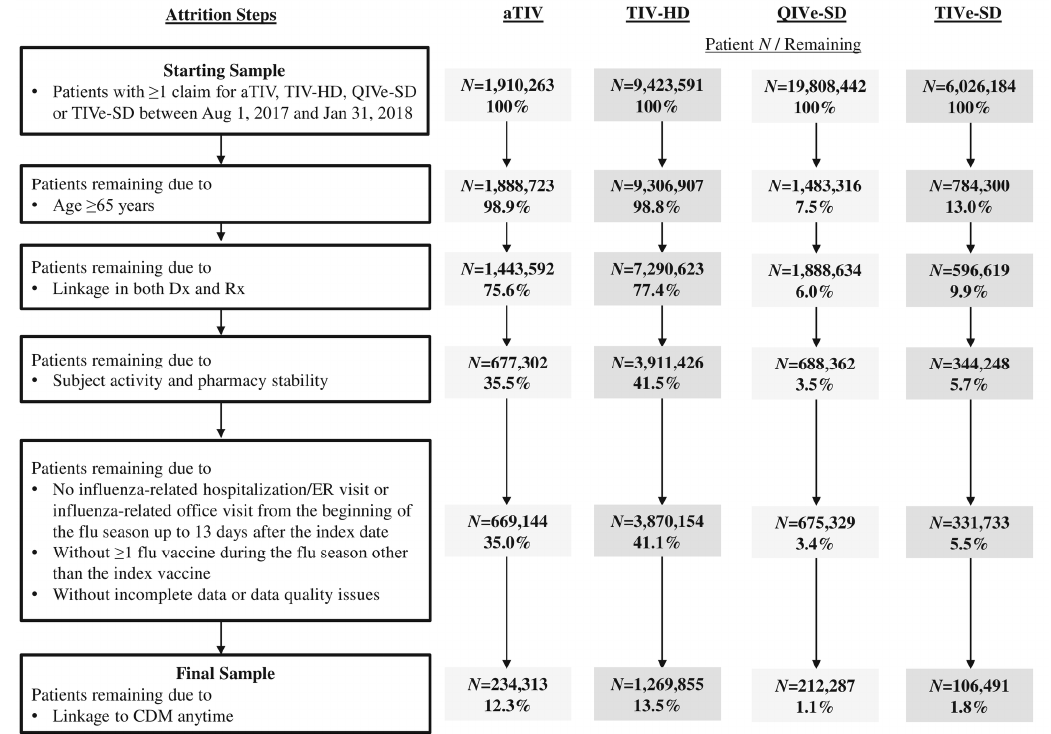
Figure 1. Patient selection. aTIV: adjuvanted trivalent influenza vaccine; CDM: Hospital Charge Data Master; Dx: Professional fee claims; QIVe-SD: quadrivalent influenza vaccine; Rx: Prescription claims: TIV-HD: high-dose trivalent influenza vaccine; TIVe-SD: standard-dose trivalent influenza vaccine.